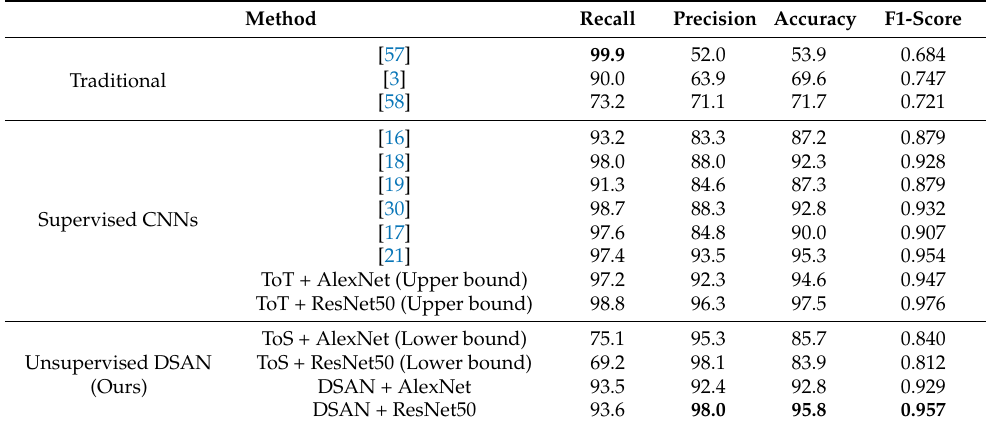
Table 5. Quantitative results of traditional handcraft feature-based methods, supervised CNNs, and DSAN on the testing set of FD-dataset.